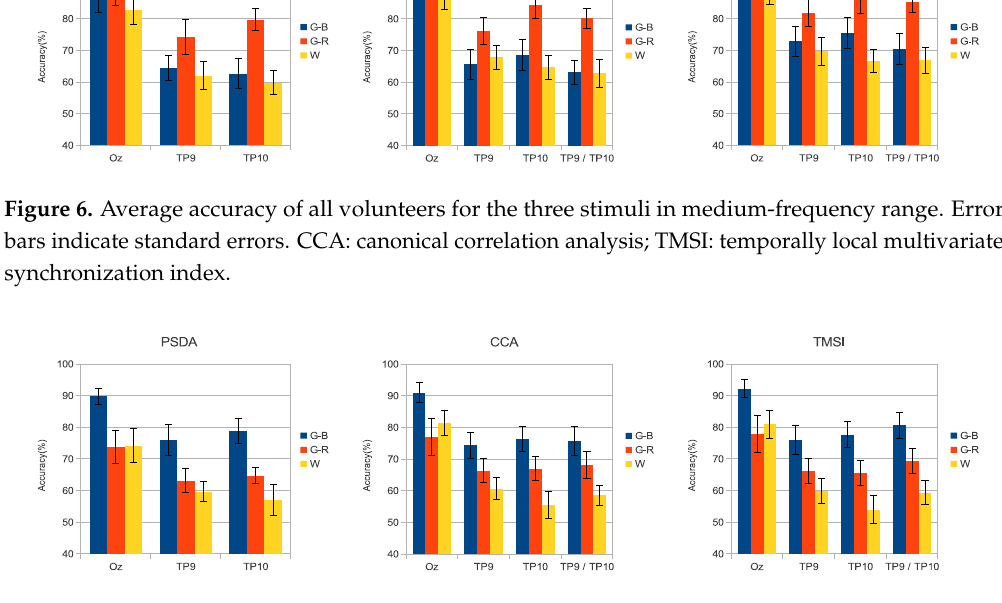
Figure 7. Average accuracy of all volunteers for the three stimuli in high-frequency range. Error bars indicate standard errors.